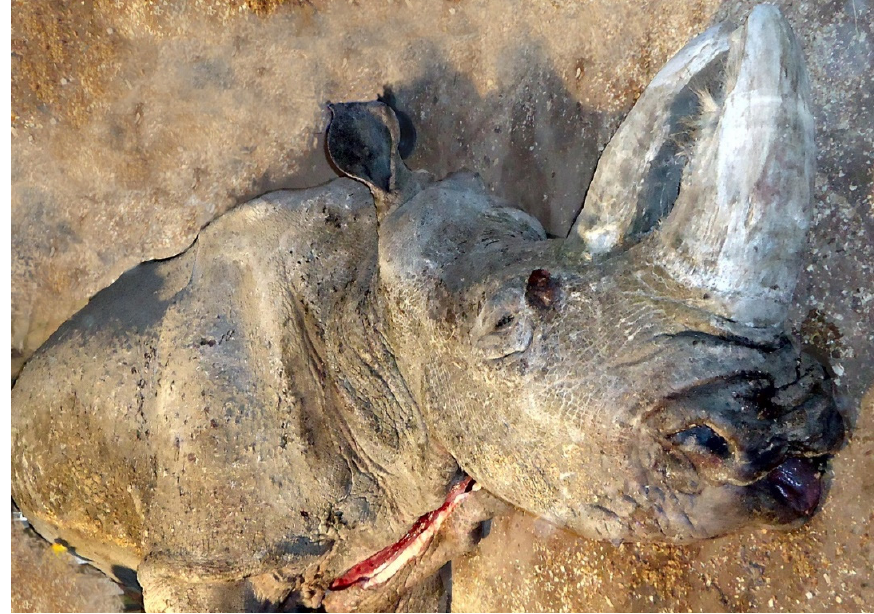
Figure 1. 48-year-old white rhinoceros female ( Ceratotherium simum , Burchell 1817), which died in Kiev Zoo, Ukraine.